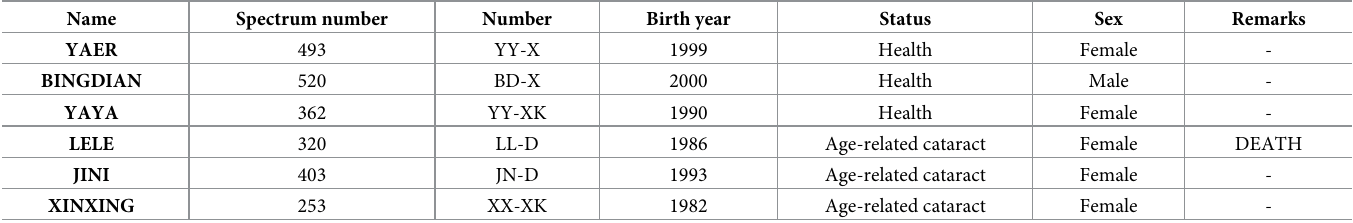
Table 1. Basic characteristics of giant